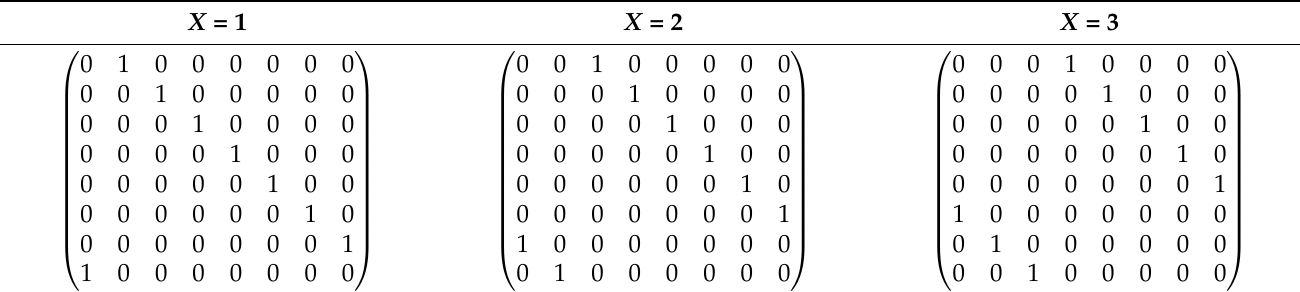
Table 8. Quantum claim